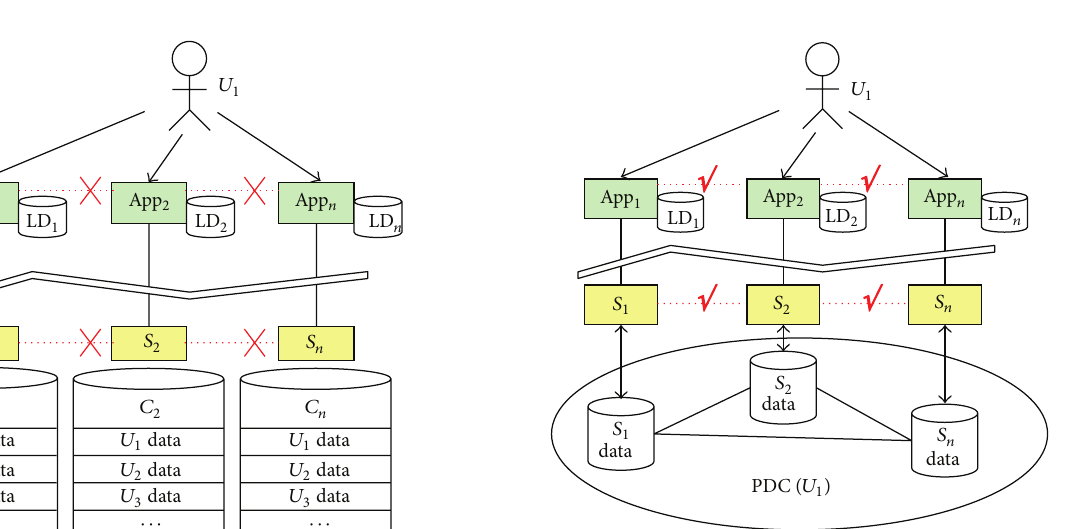
Figure 1: Service-centric personal data management.